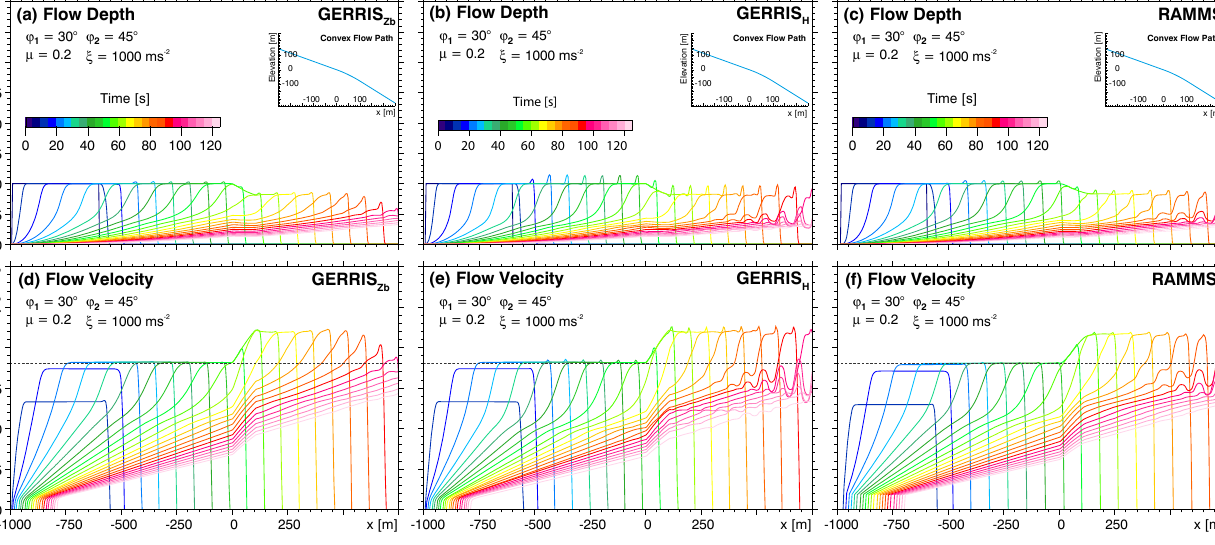
Figure 6. Time series of longitudinal profiles plotted every 5s for flow depth and flow velocity of a granular fluid on a convex slope with ϕ = 30 ◦ , ϕ = 45 ◦ , and a smooth transition between the two segments. Profiles are obtained from numerical solutions of (a, d) GERRIS Zb , (b, e) GERRIS H , and (c, f) RAMMS. The insets show the topographic